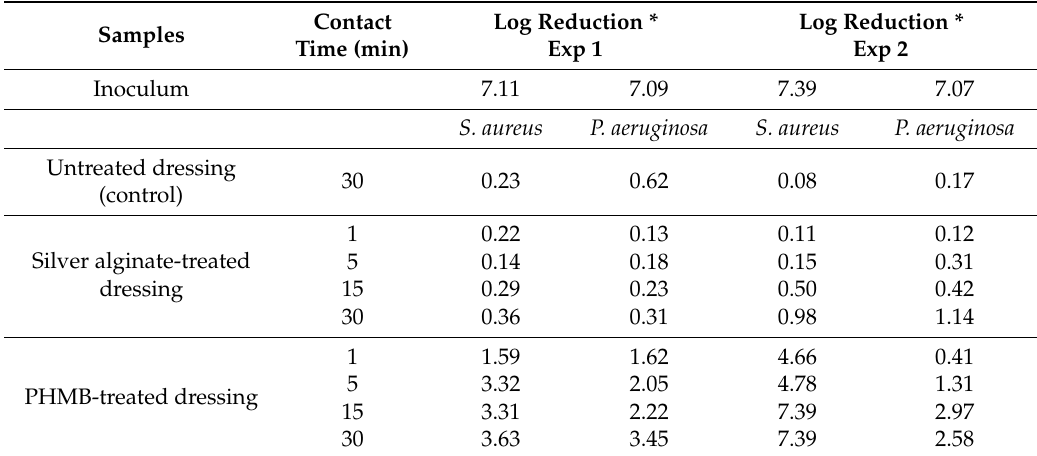
Table 6. Biocidal efficacy of commercial silver alginate and polybiguanide (PHMB) wound dressings.